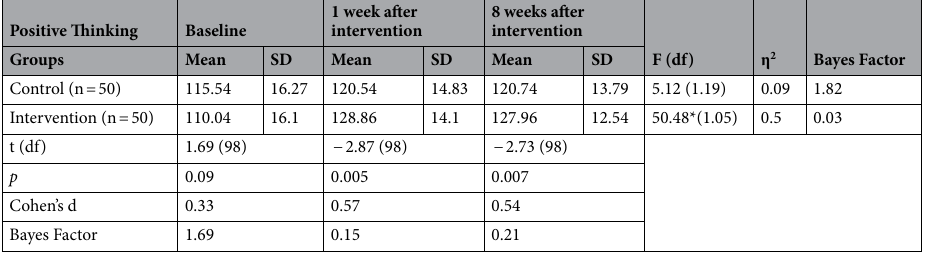
Table 2. The mean scores of positive thinking in the study groups. * p <